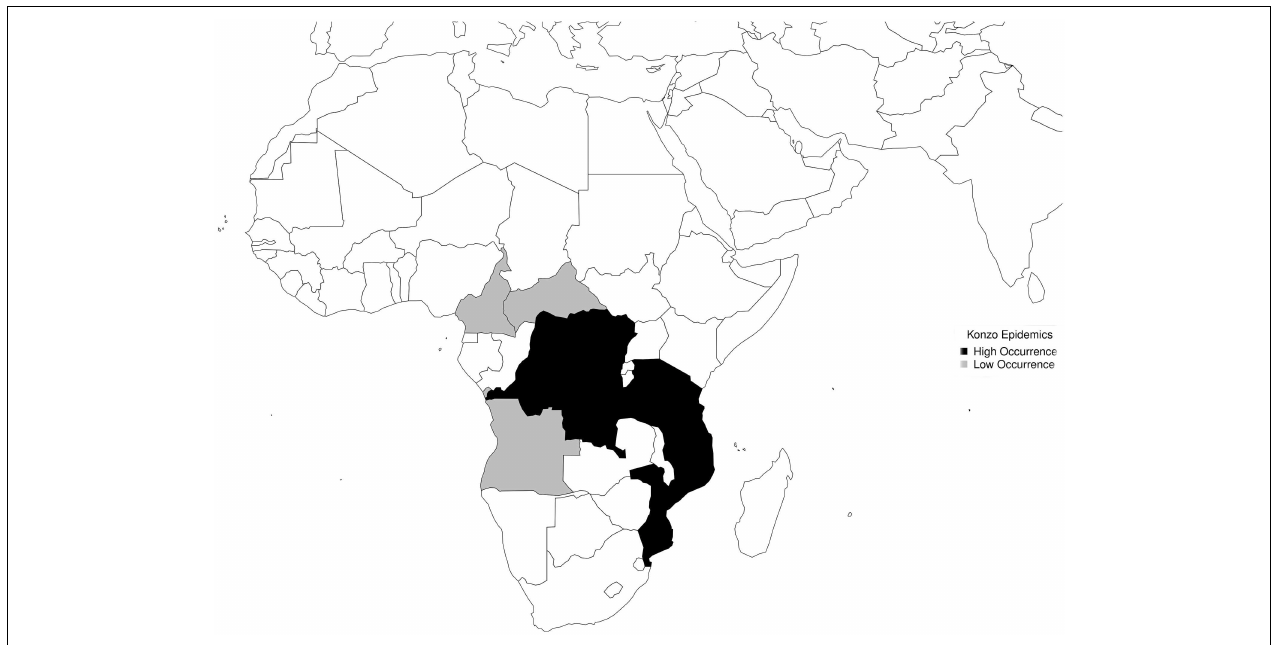
FIGURE 4 | Spatial